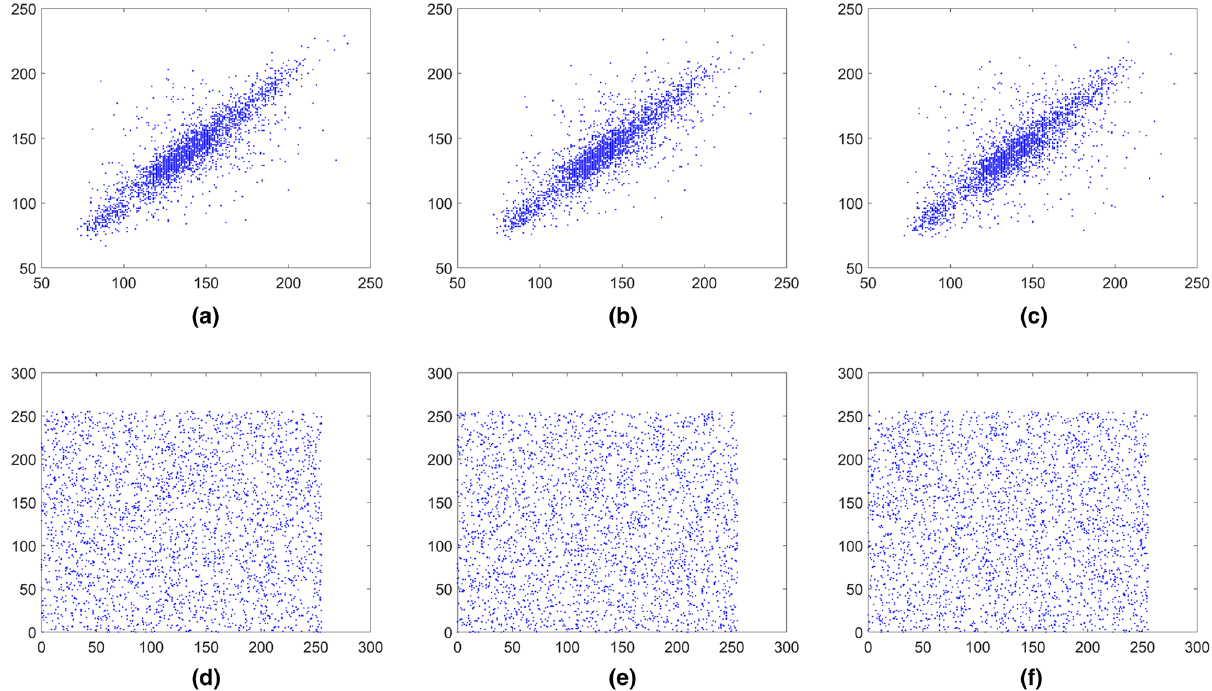
Figure 16. Distribution of adjacent pixels of the image 3.2.25 and its encrypted images. (a) Horizontal direction of the image, ( b ) vertical direction of the image, ( c ) diagonal direction of the image, ( d ) horizontal direction of the encrypted image, ( e ) vertical direction of the encrypted image, ( f ) diagonal direction of the encrypted image.